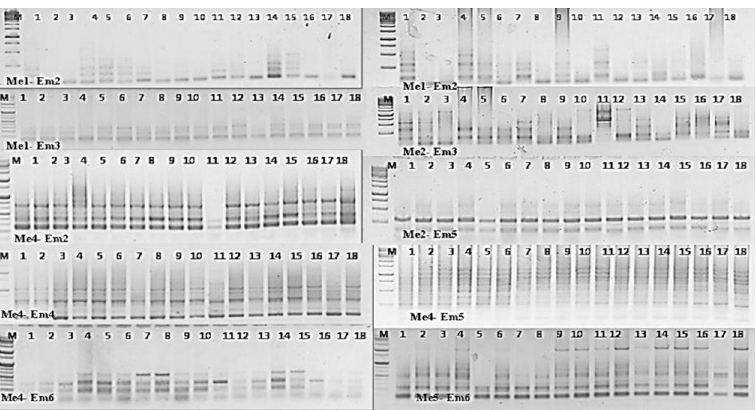
Fig 4. Amplification profile generated by 14 SRAP primers in 18 wheat genotypes. (M) molecular marker (100 bp); lanes 1–18.